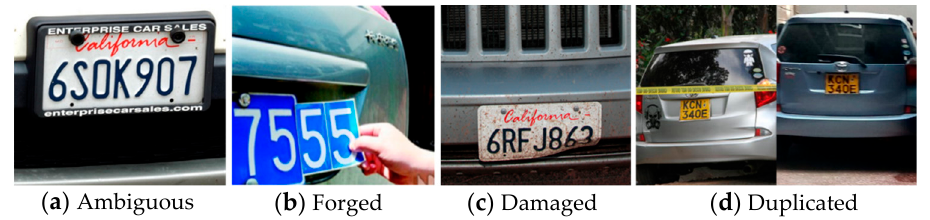
Figure 1. Some cases that cause failure of the license plate recognition-based MMR systems.